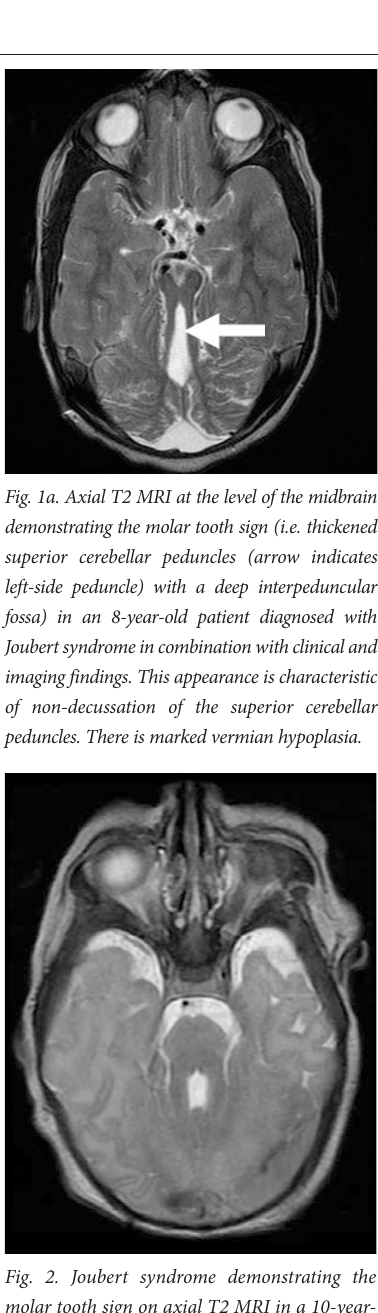
Fig. 3b. Fetal MRI, coronal T2, in the same fetus, demonstrating enlarged echogenic kidneys. This finding in conjunction with the molar tooth sign is consistent with a diagnosis of the JSRD renal